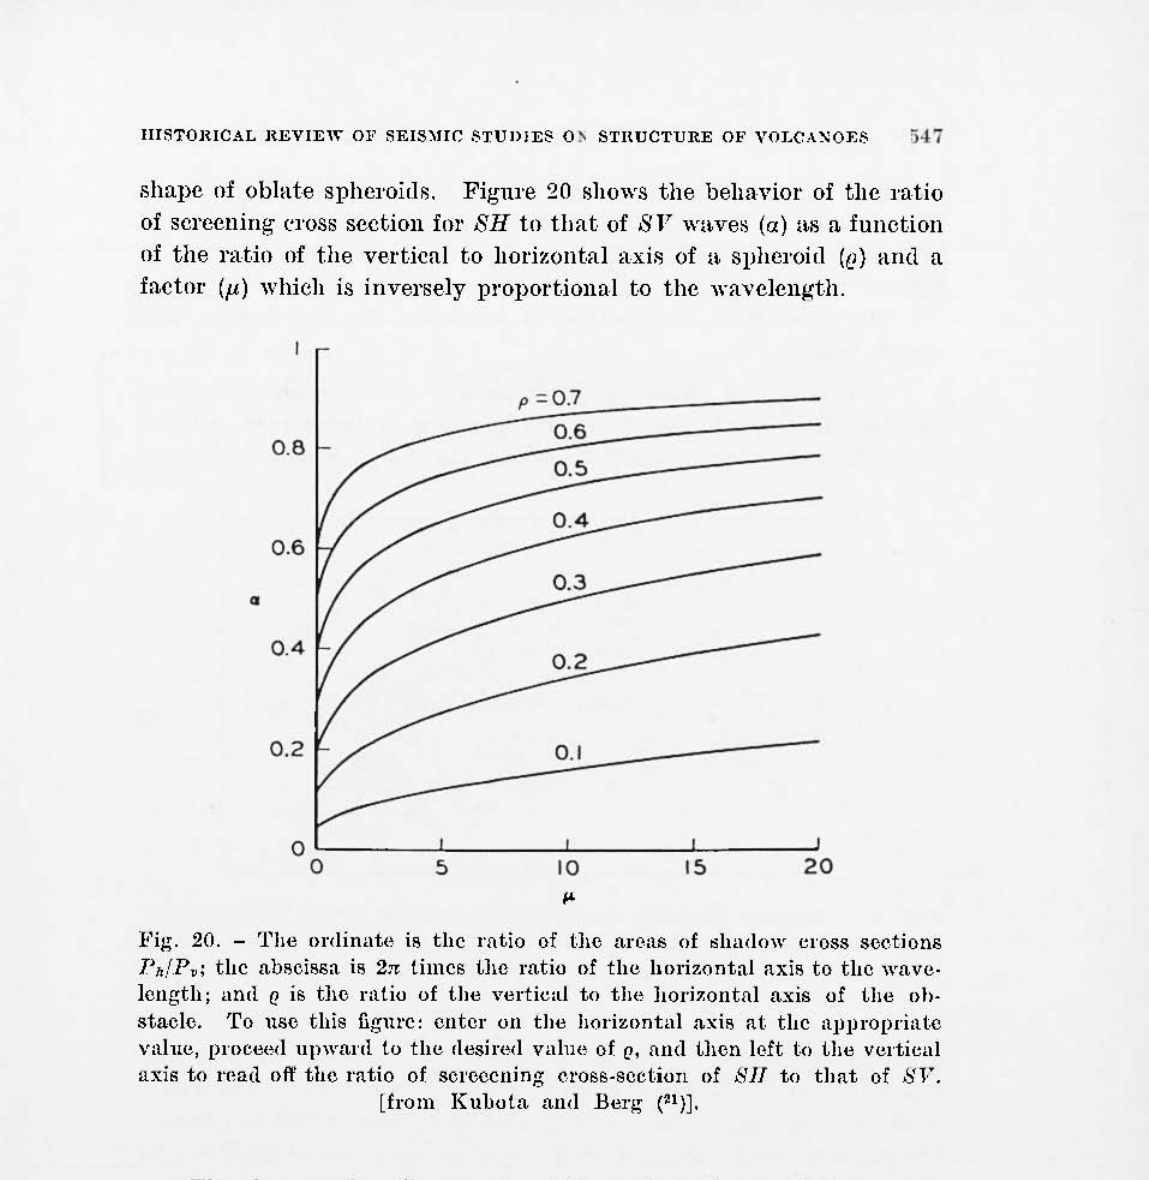
Fig. 20. - 'l'he oJ'(linate is thc ratio of the ureas of ~hl\(low cross sections l'h/P,; thc ubsci8Sa is 2n timcs the rutiu of thc horizontal axis to thc wuvc· lcngth; and Q is the ratiu of the vertieal to the hori7.ontal uxis uf the oh· stacle. To use this figurc: entcr un the horizontal uxis at thc ajljll'opriate valuc, pl'Ocee<! uJlwunl to thc <!esire<! vahw of Q, amI then !eft to the vcrtieal axis to realI off thc ratio of screecning cross·scctiun of 8JJ to that of 81-'. [from Kubutu uw! Berg